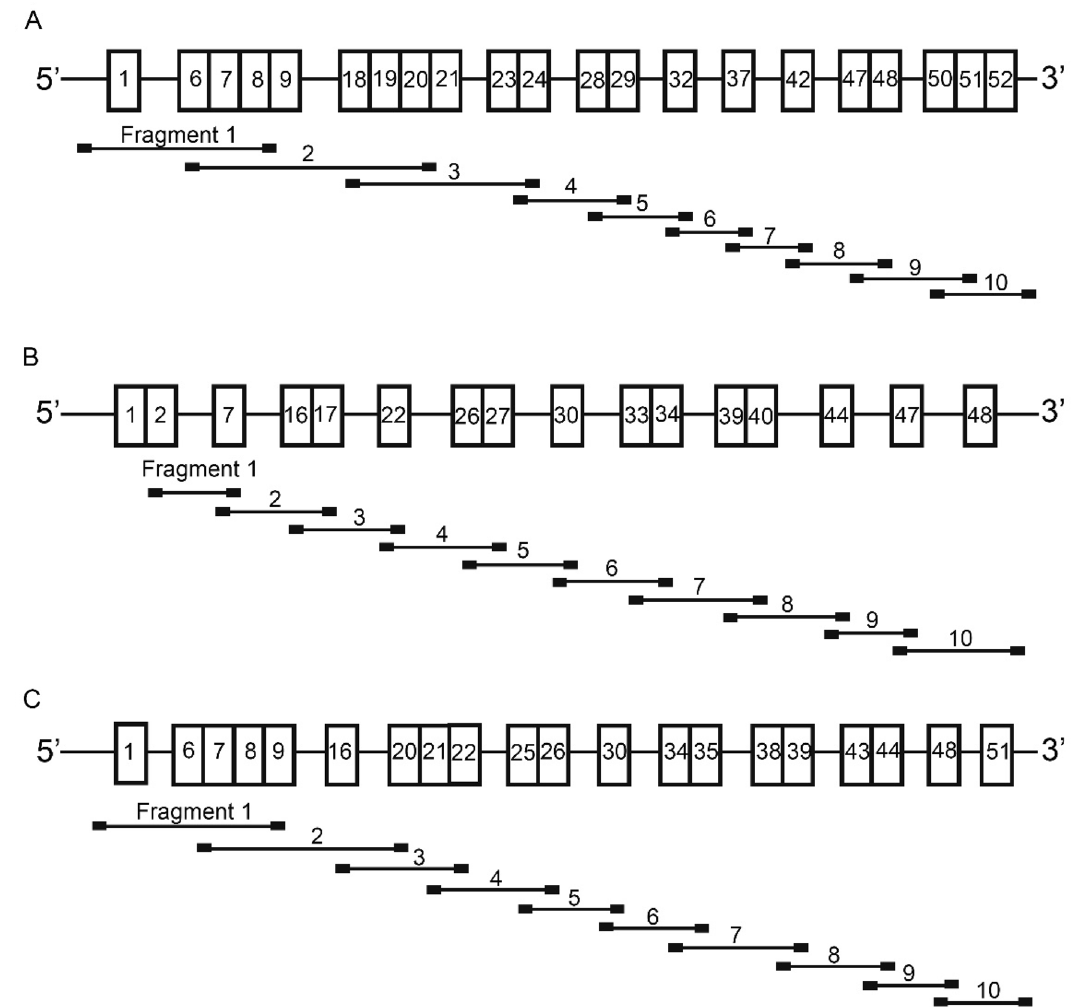
Figure 6. Strategy for amplification of the COL4A3-5 cDNAs by PCR. ( A ) The entire coding region of COL4A3 mRNA was demonstrated by all boxes. ( B ) The entire coding region of COL4A4 mRNA was showed by all boxes. ( C ) The entire coding region of COL4A5 mRNA was indicated by all boxes. The exon numbers of each gene were represented by the numbers in the boxes. The localizations of the ten amplified fragments were demonstrated with the primer site (black